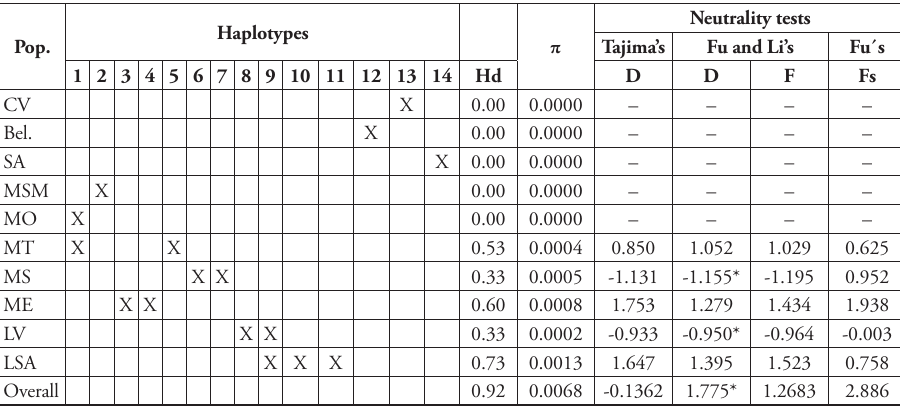
Table 2. Summary of genetic variability of ten populations of C. pampeanus based on mitochondrial DNA sequences. Populations (Pop) are as follows: Capão do Valo (CV), Belvedere (Bel.), Santo Amaro (SA), Morro São Maximiliano (MSM), Morro do Osso (MO), Morro da Tapera (MT), Morro Santana (MS), Morro da Extrema (ME), Lombas de Viamão (LV) and Lombas de Sto. Antonio (LSA). Numbers from 1 to 14 indicate number of haplotypes found in each population. Hd, haplotype diversity; π, nucleo- tide diversity. Neutrality tests performed: Tajima´s (D); Fu and Li’s (D and F); Fu's (Fs). Asterisks indicate significant values, P <